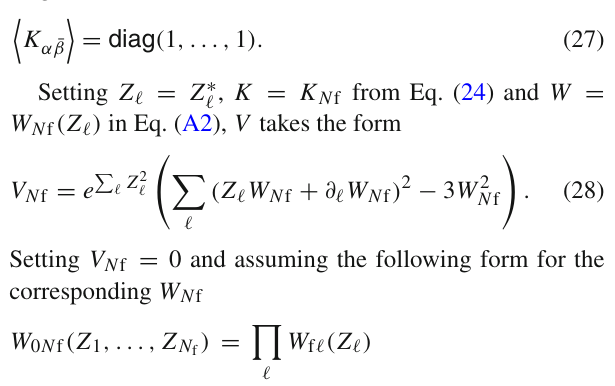
Fig. 1 The (dimensionless) SUGRA potential 10 2 V f / m 2 m 2 Eq. (16) as a function of z and ¯ z in Eq. (17) for the inputs shown in column A of Table 1. The location of the dS vacuum in Eq. (10b) is also depicted by a thick black